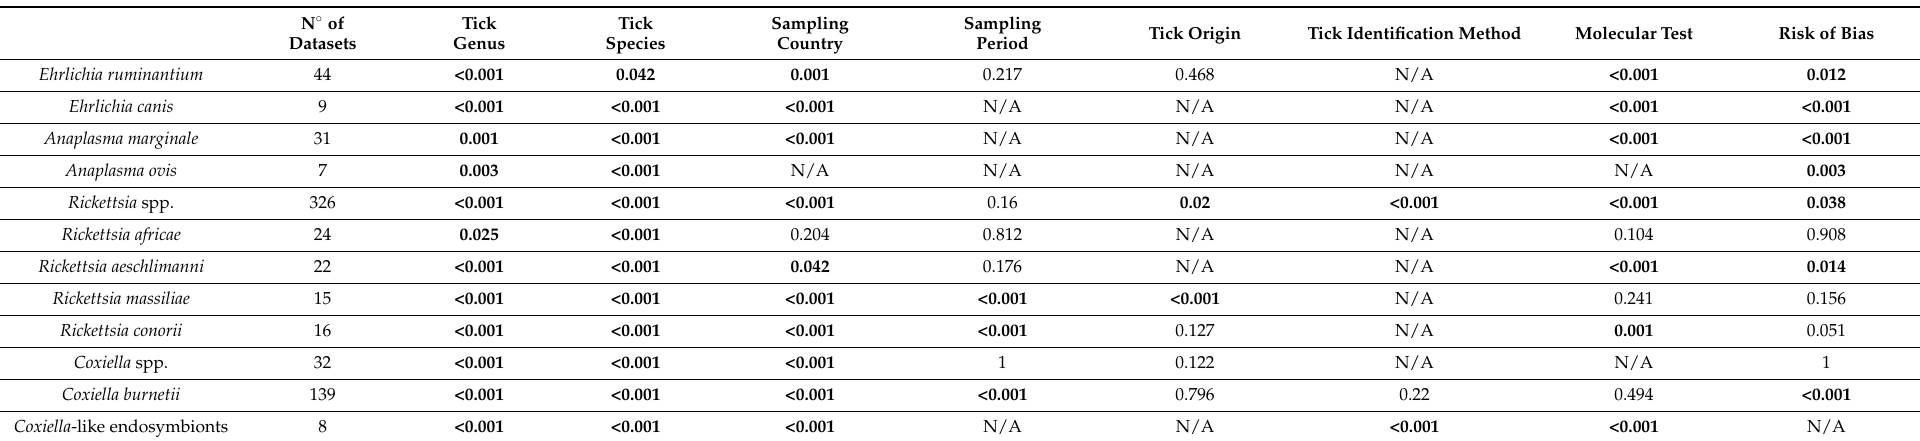
Table 3. Statistical significance ( p -values) of the moderators selected for our subgroup analysis.